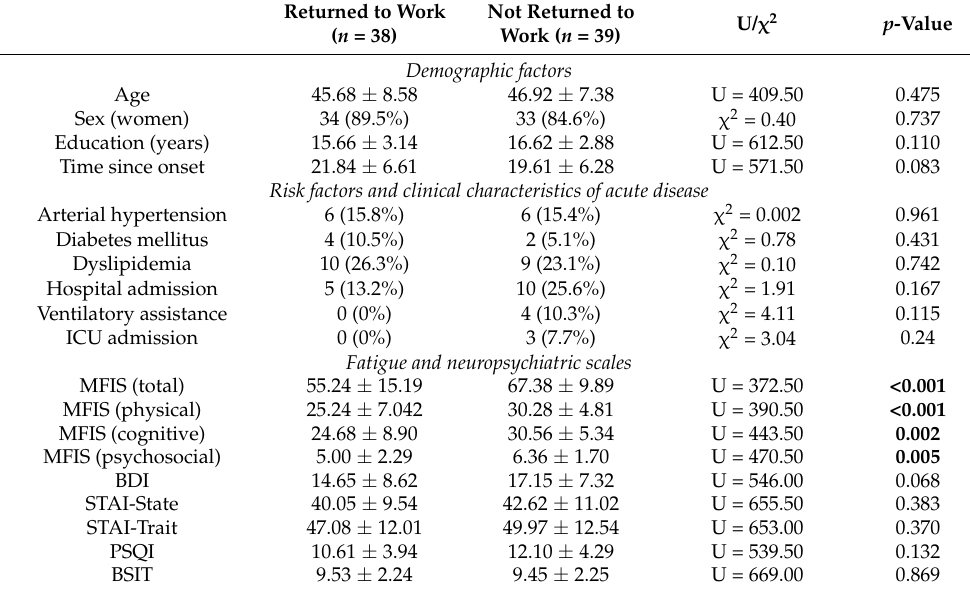
Table 2. Comparison of patients on active working or not at the moment of the assessment. Returned to Work ( n =